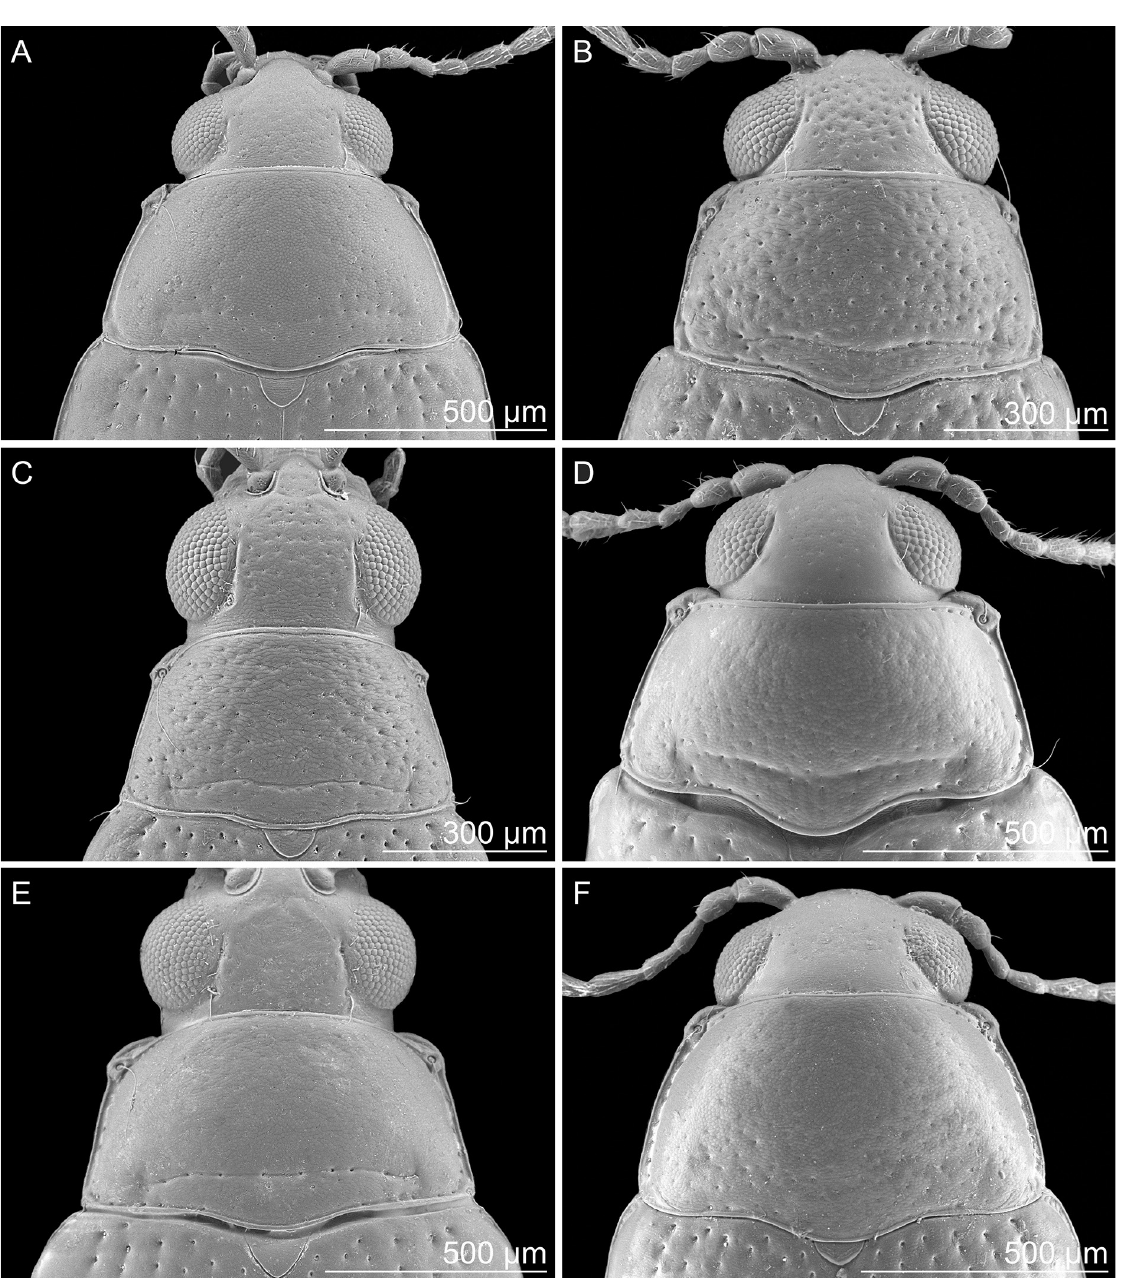
Fig. 5. Head and pronotum. A . Arsipoda povilaensis sp. nov, Pic d’Amoa. B . A. punctata sp.